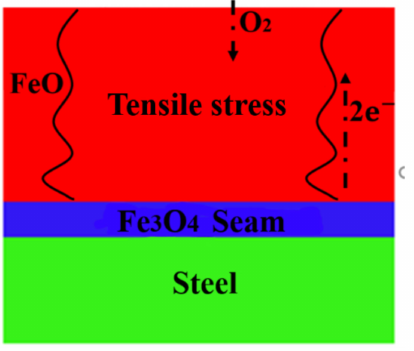
Figure 12. Schematic diagram of the stress state of the interface between the oxide layer and the matrix. For the two-phase isomerized Fe 3 O 4 seam layer, when the rolling reduction rate is low, the fiber texture of <110> appears along the growth direction of the oxide layer. This